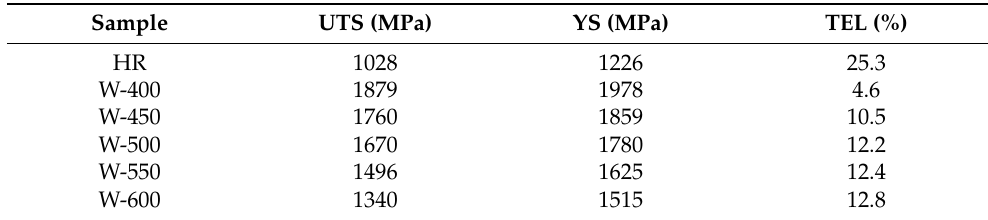
Table 3. Tensile properties of 18Mn/40Si2CrMo multilayer composite steel with different warm rolling